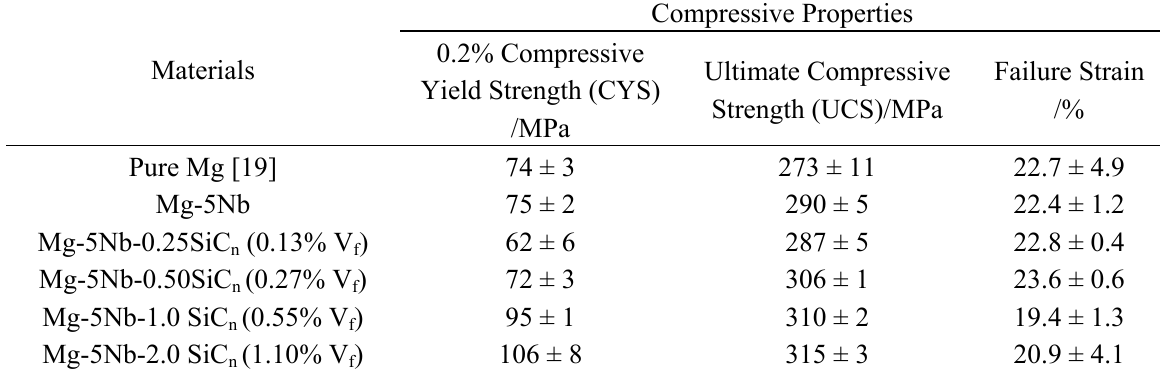
composites with varying SiC n